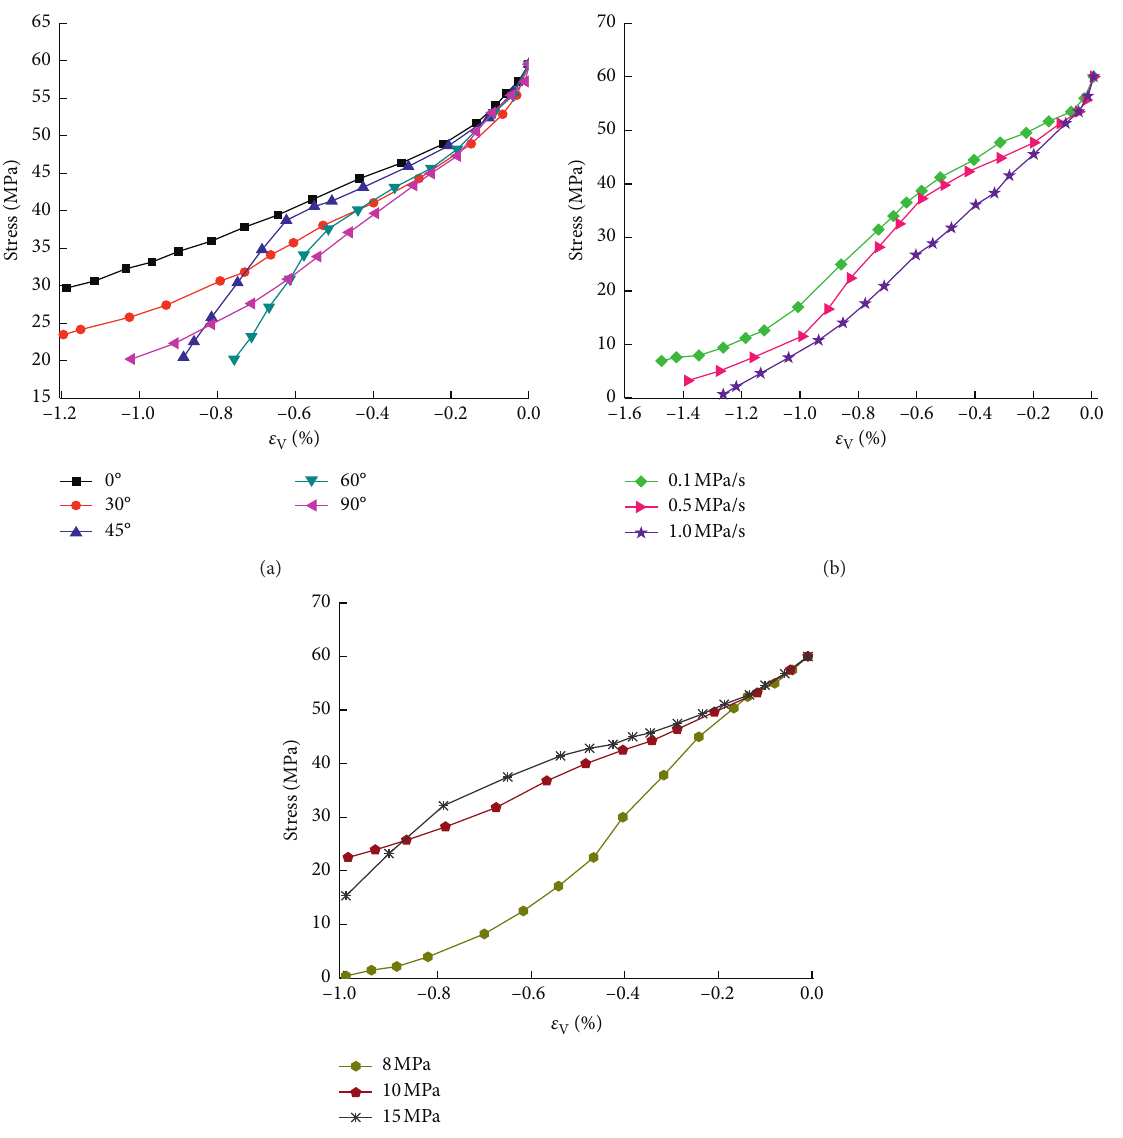
Figure 5: ( σ − σ ) − ε v curves of cracked specimens under axial unloading and radial unloading conditions. (a) Effect of crack angle. (b) 1 3 Effect of unloading rate of confining pressure. (c) Effect of initial confining